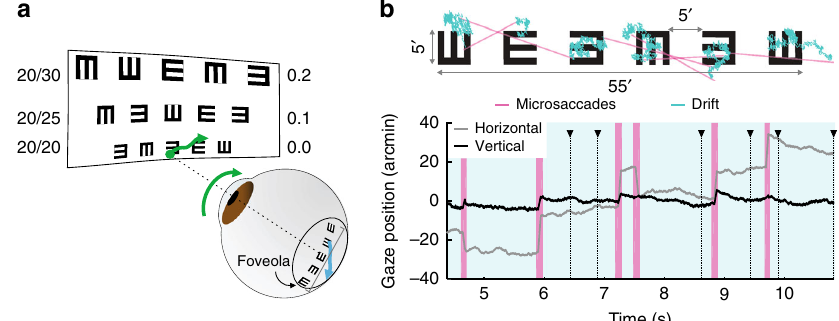
Fig. 1 Fixational eye movements and Snellen acuity. a Several lines from a standard eye chart. The 20/20 line corresponds to a minimum angle of resolution (MAR) of 1 arcmin (logMAR = 0). Fixational eye movements (green arrows) cause the image to move on the retina (blue arrow). b Example of eye movements during examination of the 20/20 line. An oculomotor trace is shown superimposed onto the stimulus (top) and over time (bottom). Green and pink colors mark the periods of drifts and microsaccades, respectively. The black triangles mark the time at which the subject reported each optotype in the array. Source data are provided as a source data fi